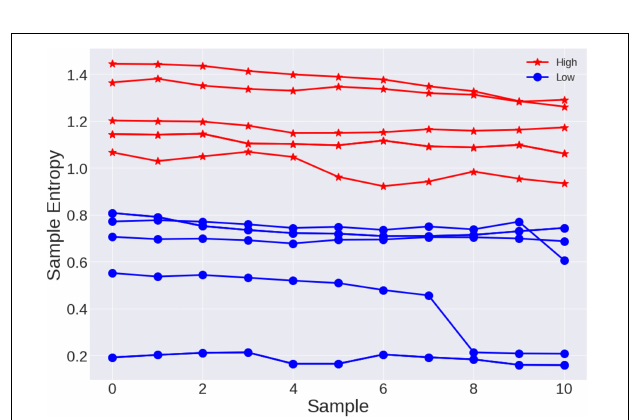
FIGURE 10 | Five time series of active young subjects (red) and five time series of sedentary young subjects (blue) during the stress tests (4 miles per hour). The points represent SampEn values for subseries obtained from the time series with overlapping. For active subjects the average change in sampling entropy is –0.10, and for sedentary subjects is